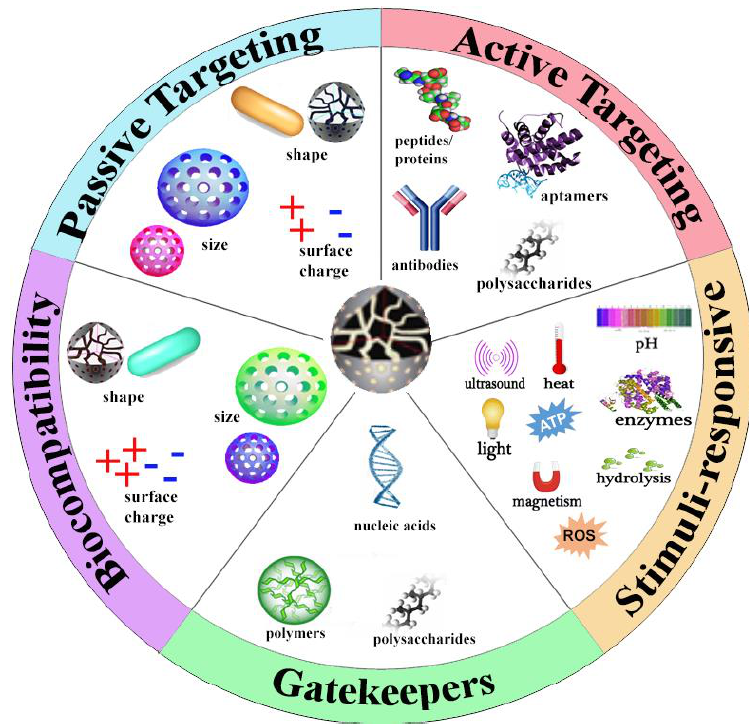
Figure 1. Characteristics of MSNs that drive theragnostic effect.